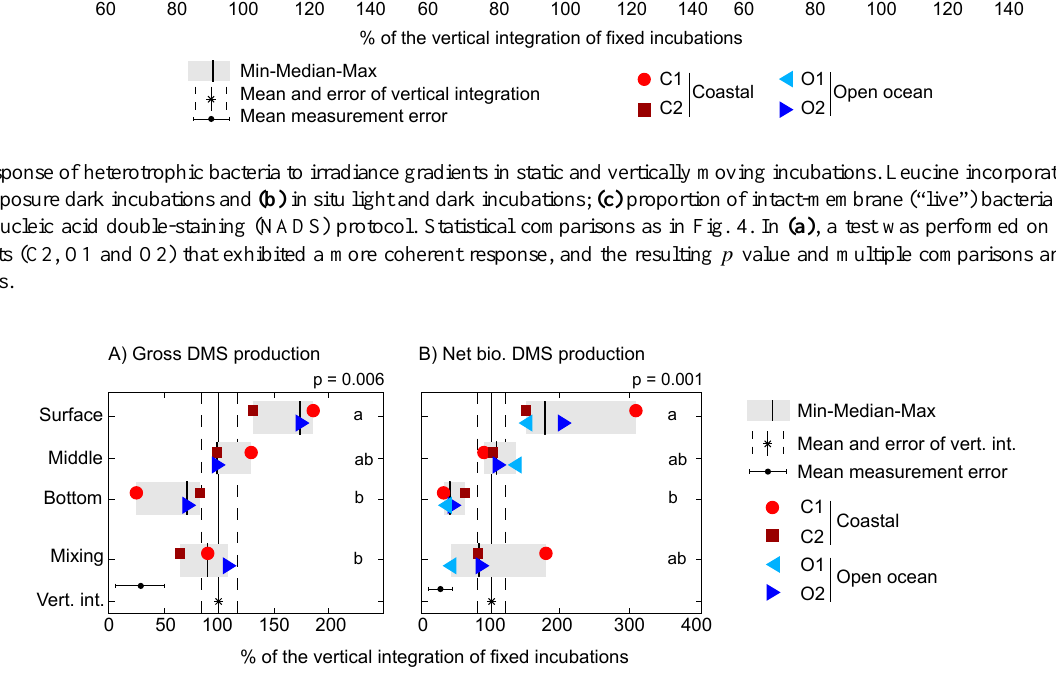
Fig. 6. Response of community DMS production to irradiance gradients in static and vertically moving incubations. (a) Gross DMS produc- tion (GP DMS , DMDS-amended incubations); (b) net biological DMS production (non-amended incubations; equivalent to GP DMS minus bacterial DMS consumption). Statistical comparisons as in Fig. 4. In (b) , a test was performed on a subset of experiments (C2, O1 and O2) that exhibited a more coherent response. Multiple comparisons did not show different patterns from those in the entire data set, although the p value decreased ( p = 0 .